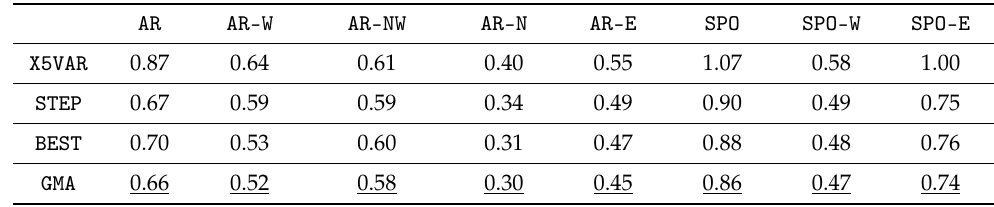
Table 3. nRMSE statistic for the hindcast analysis under LOOCV . The best result for each region is